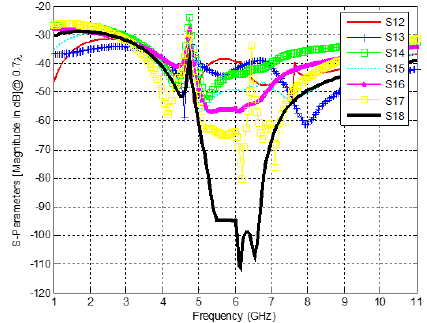
FIGURE 12. Parametric study of the broadband mutual coupling for different values of inter-element distance (0.7 λ ) (4 antennas array)